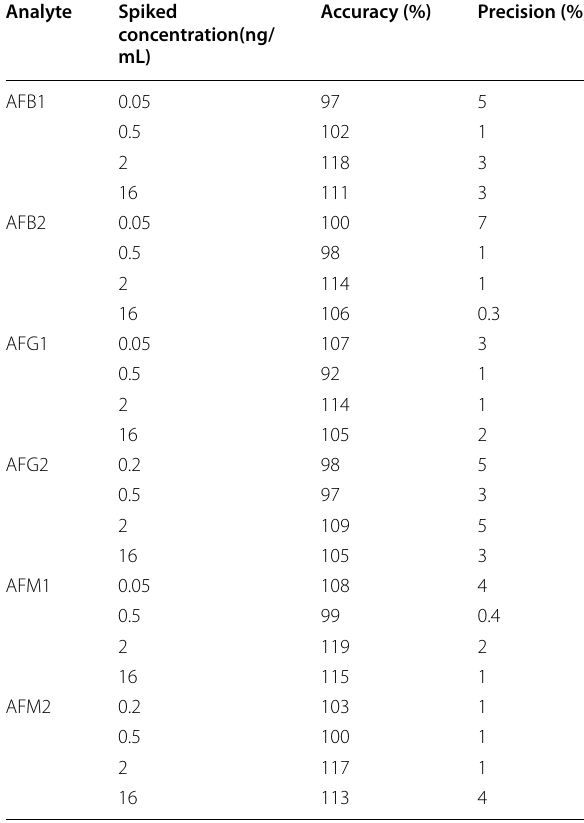
Table 4 Freeze–thaw